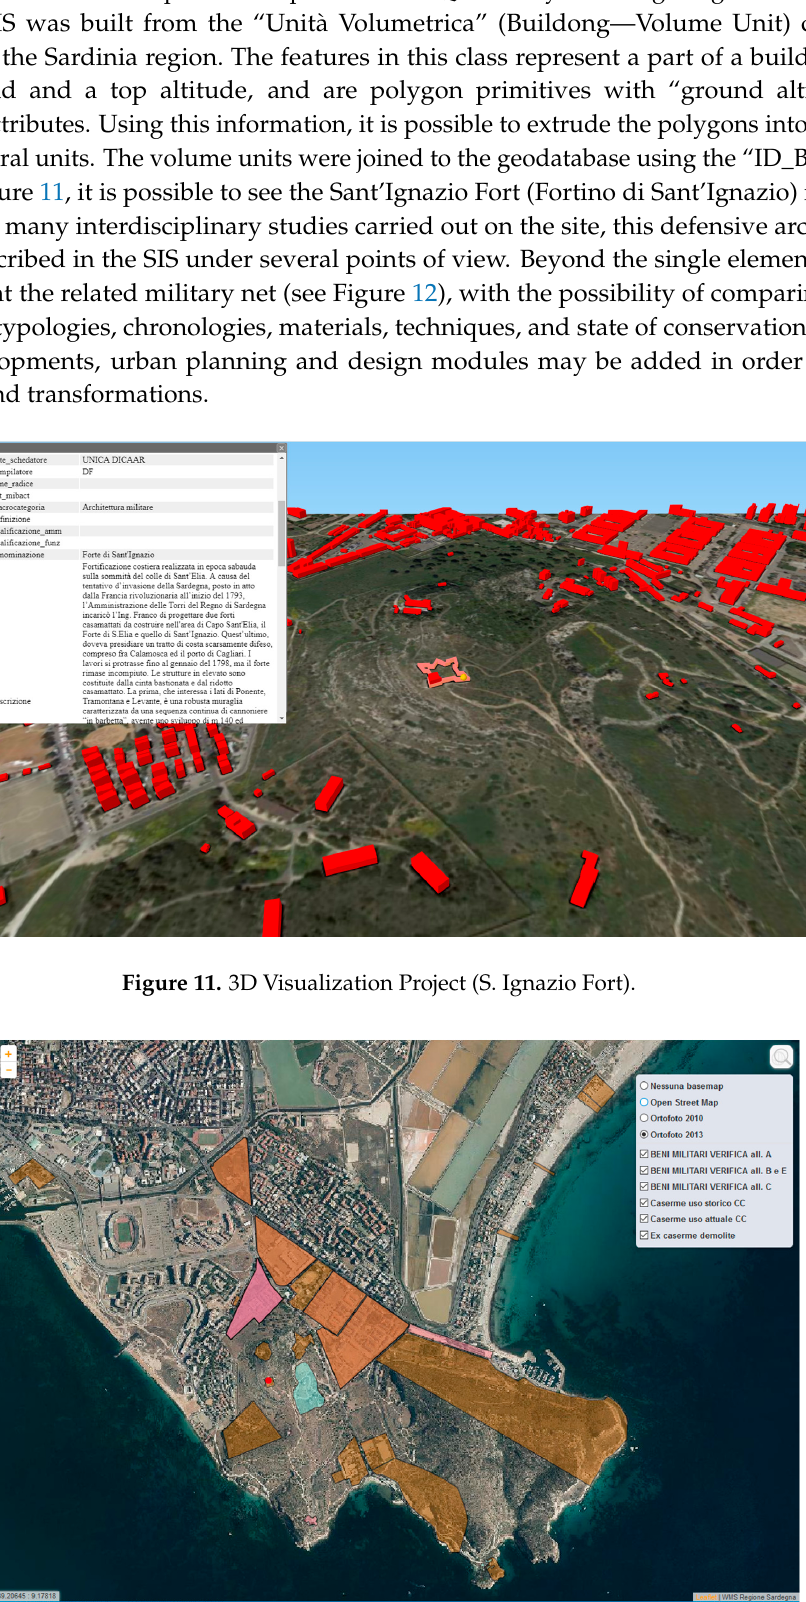
Figure 12. Areal Mapping of the Military Network in the Surrounding of the S. Ignazio Fort (red